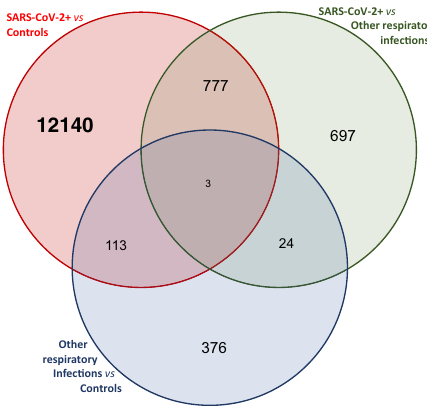
Fig. 3 Overlap of differentially methylated CpGs between disease groups. Venn diagram of overlaps between SARS-CoV-2 + – Control EWAS (13,033 signi fi cant probes), SARS-CoV-2 + – other respiratory infection EWAS (516 signi fi cant probes), and other respiratory infection – Control EWAS (1501 signi fi cant